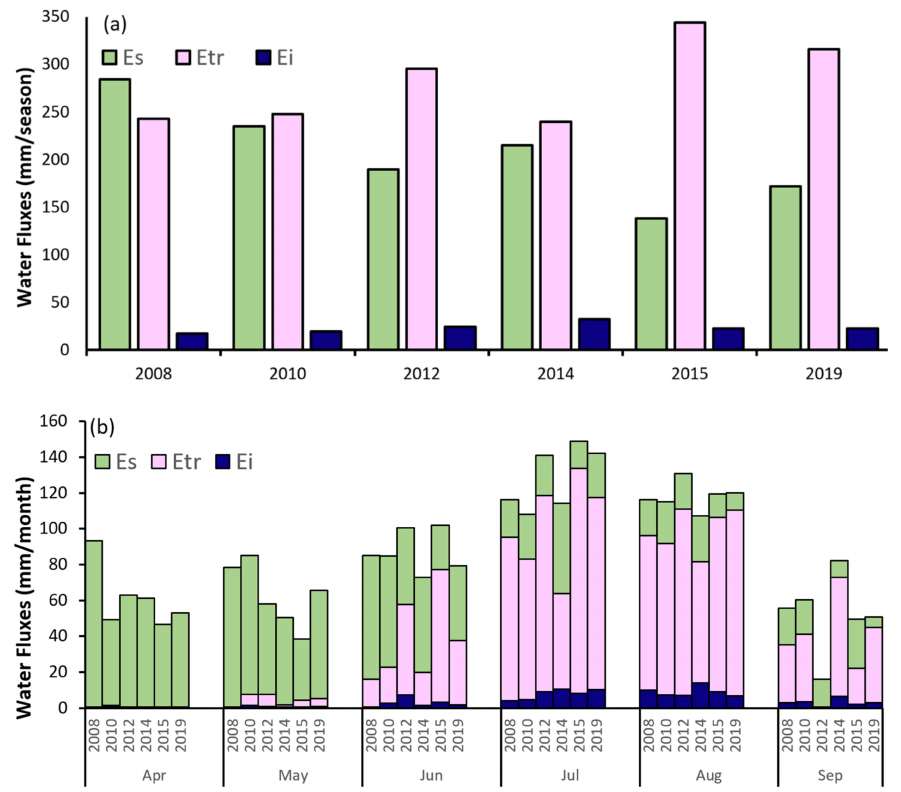
Figure 10. ( a ) The crop-season partitioning of evapotranspiration into soil evaporation (green), plants transpiration (pink), and vegetation evaporation (blue) for each maize season; ( b ) the same as in ( a ) but over a monthly time scale for